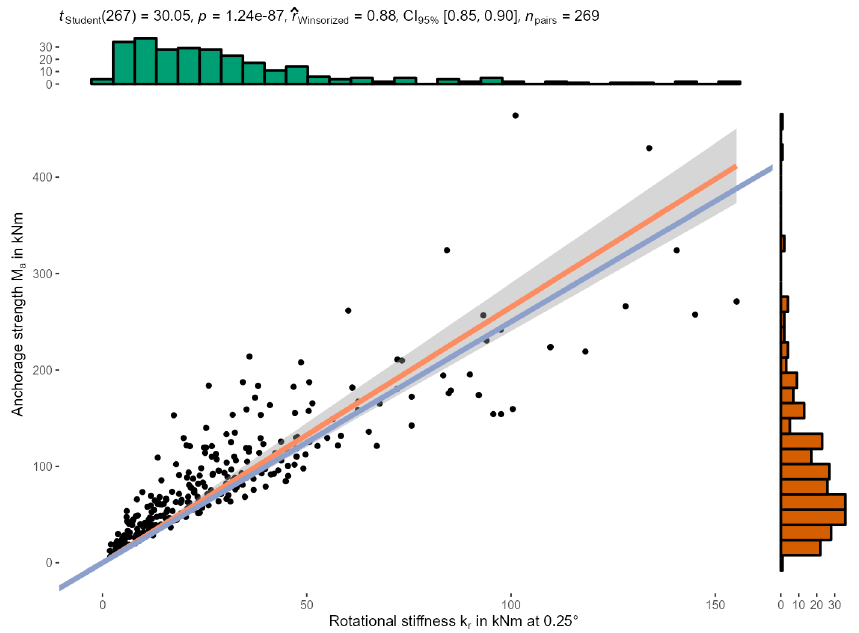
Figure 2. Robust correlation of bending moments at a root plate inclination of 0.25° k r and at failure M a . The blue line illustrates Equation